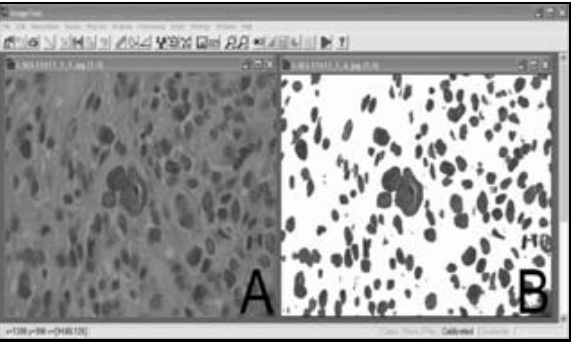
Figura 4 – Interface do programa Image Tool versão 3.0 para Windows. A: imagem original; B: após a seleção dos pixels, os núcleos estão individualizados. Cada